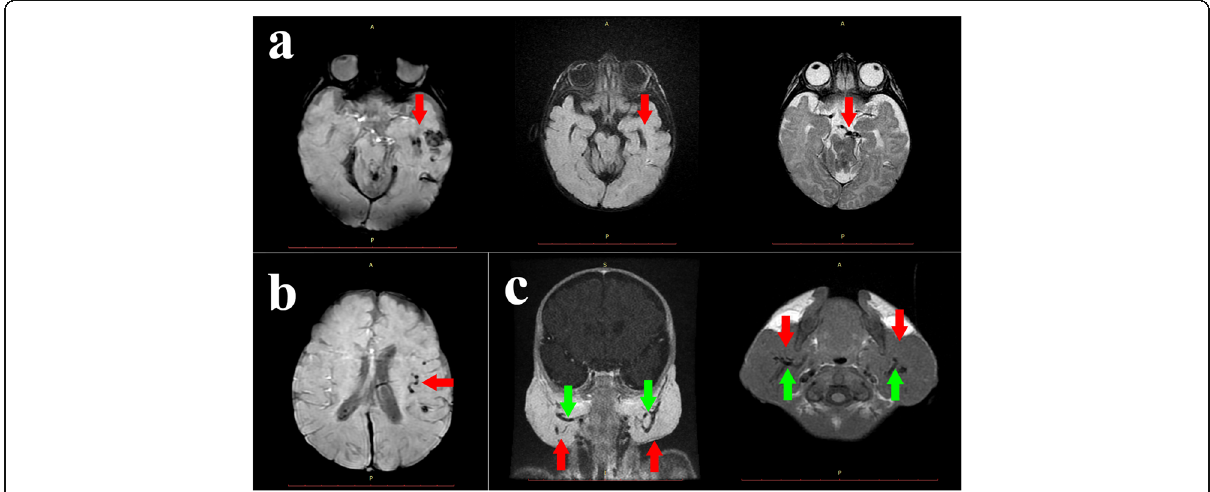
Fig. 1 MRI imaging . a Red arrows show signal abnormality in the left temporal lobe, quadrigeminal cistern, and ambient cistern with susceptibility artifact on SWAN images showing vascular malformation. b Red arrow shows serpiginous blooming artefactual signal in the left cerebral hemisphere consistent with dilated collateral vascular channels. c Red arrows show diffusely enlarged parotid glands with signal alteration and green arrows show flow voids in the parenchyma of parotid glands indicating bilateral parotid